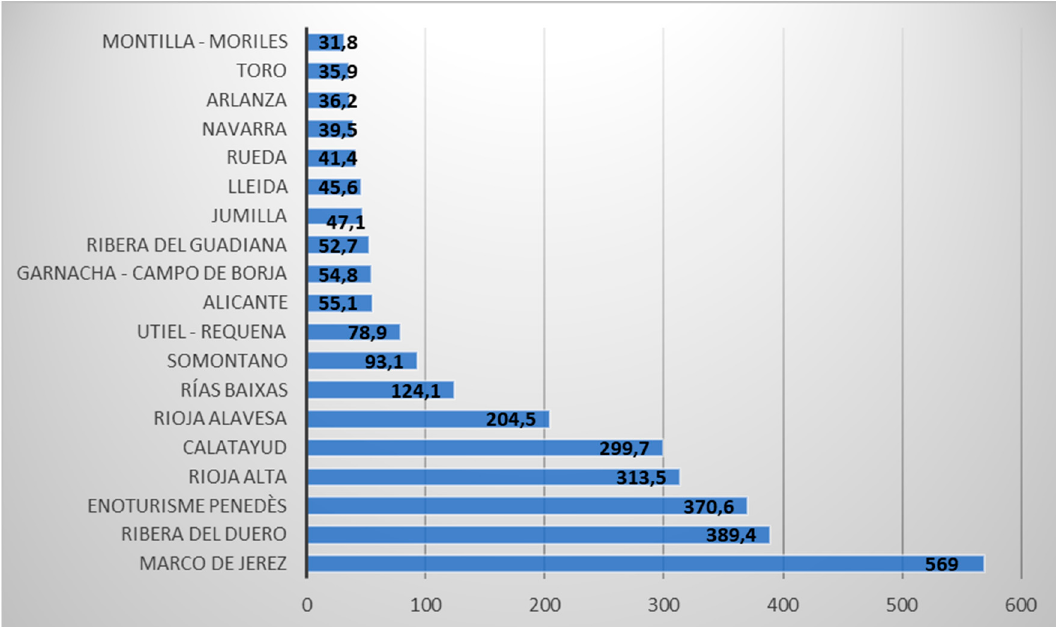
Figure 4. Number of visitors and wine routes in Spain (2019). Source: Own elaboration based on ACEVIN data [93].